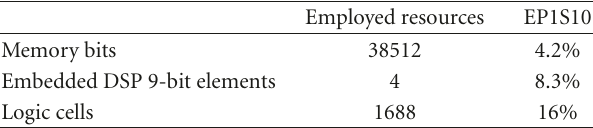
Table 2: Resource employed by a single